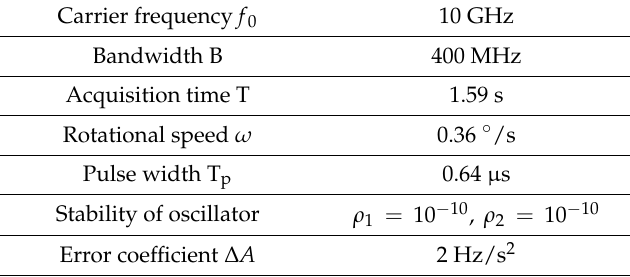
Table 1. Simulation parameters.